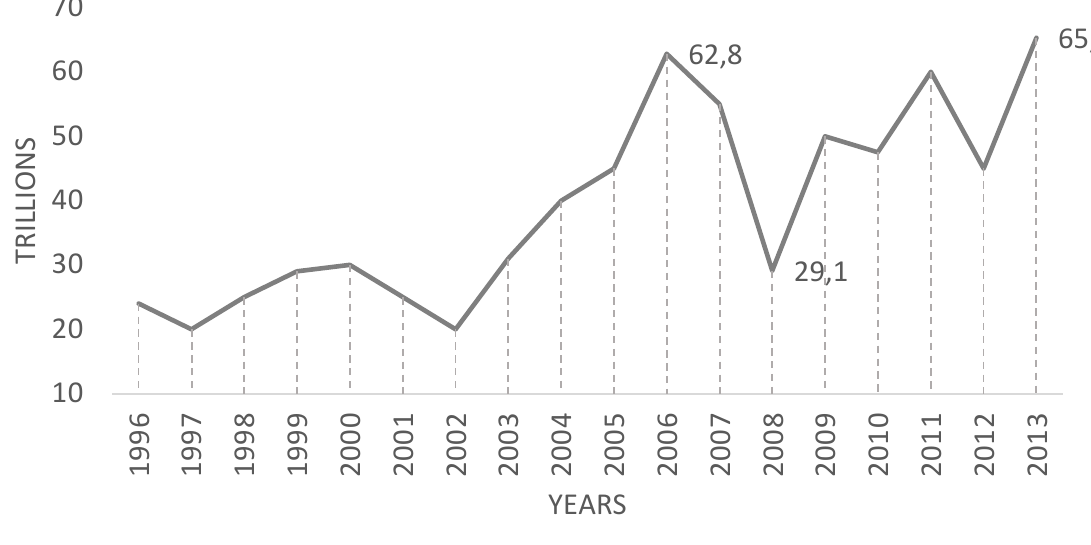
Figure 2. World stock market capitalisation from 1996 to 2013 (World Federation of Exchanges,